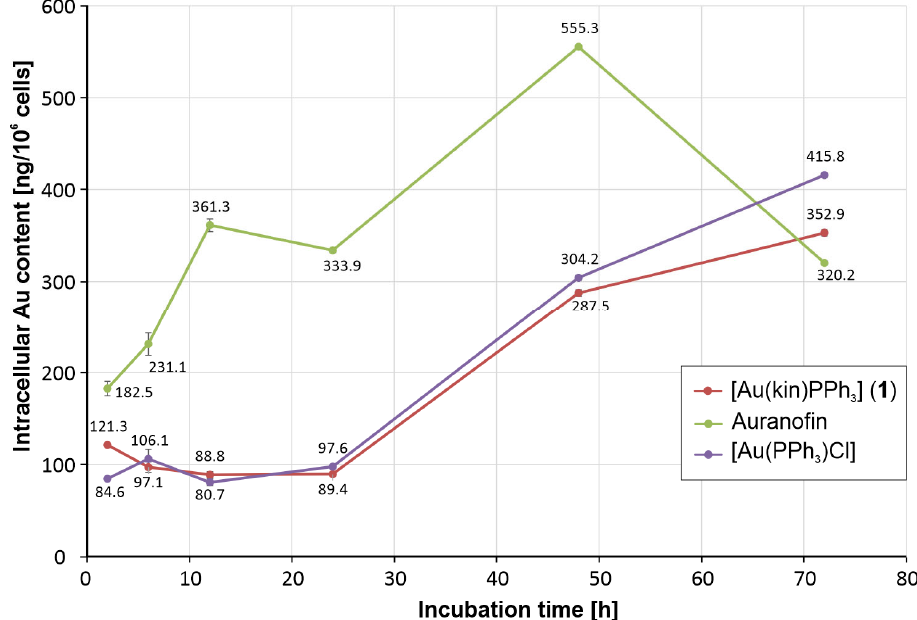
Figure 3. The intracellular gold concentration levels caused by the incubation of [Au(kin)(PPh 3 )] ( 1 ), [Au(PPh 3 )Cl], and Auranofin with A2780 cells after 2 h, 6 h, 12 h, 24 h, 48 h, and 72 h. The results were obtained by ICP ‐ MS analyses of three parallel samples and are shown as mean values with error bars corresponding to the standard deviation values of the gold concentration expressed in ng of gold per 10 6 cells.